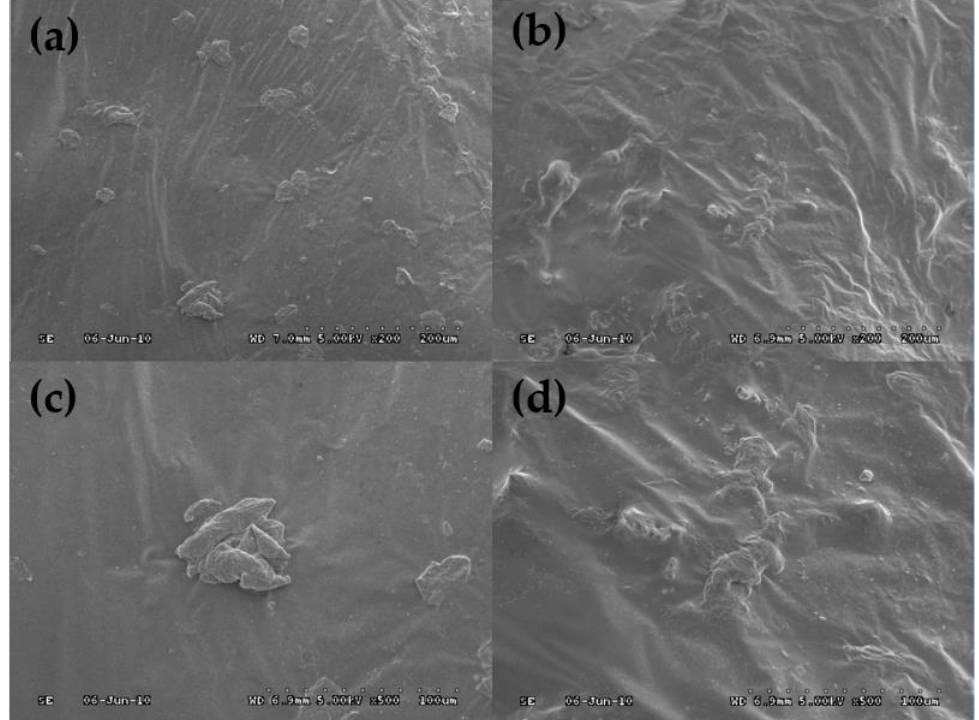
Figure 9. SEM images of CRMA and A–G–R. ( a ) The image of CRMA (200 × ); ( b ) The image of A–G–R (200 × ); ( c ) The image of CRMA (500 × ); ( d ) The image of A–G–R (500 × ).